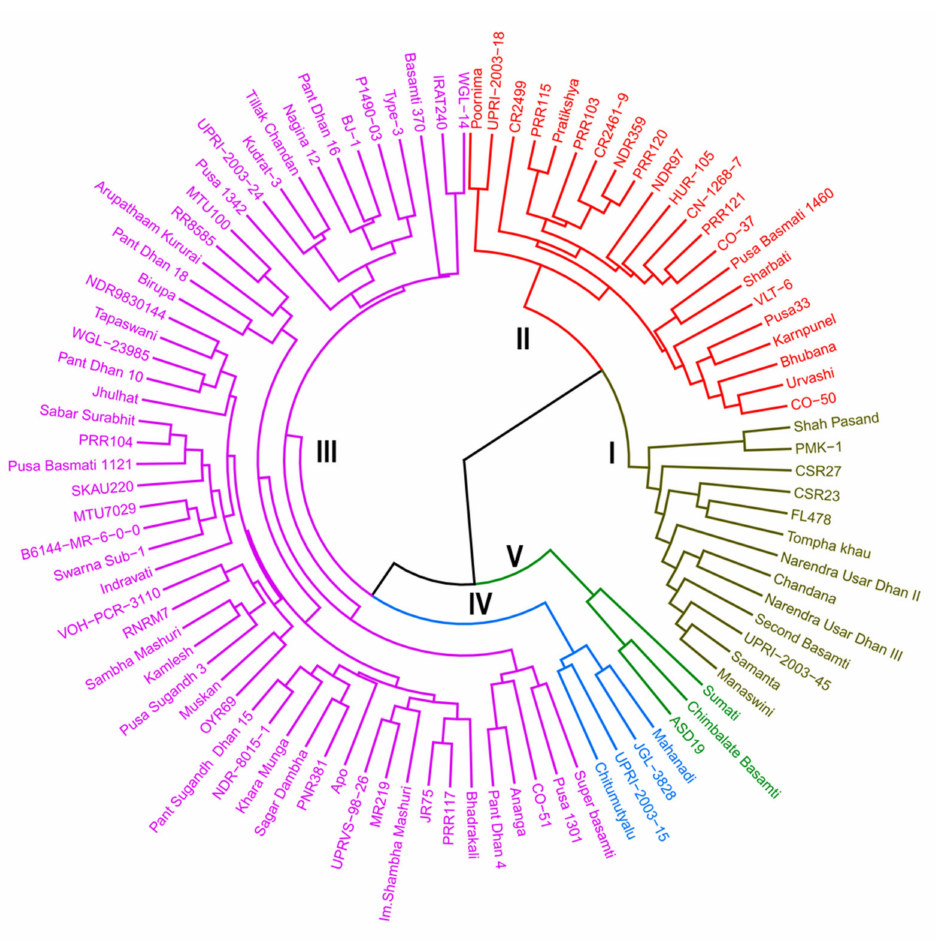
Figure 2. Phenogram of 96 rice genotype based on salt tolerance score and 13 morpho-physiological characters recorded under salt